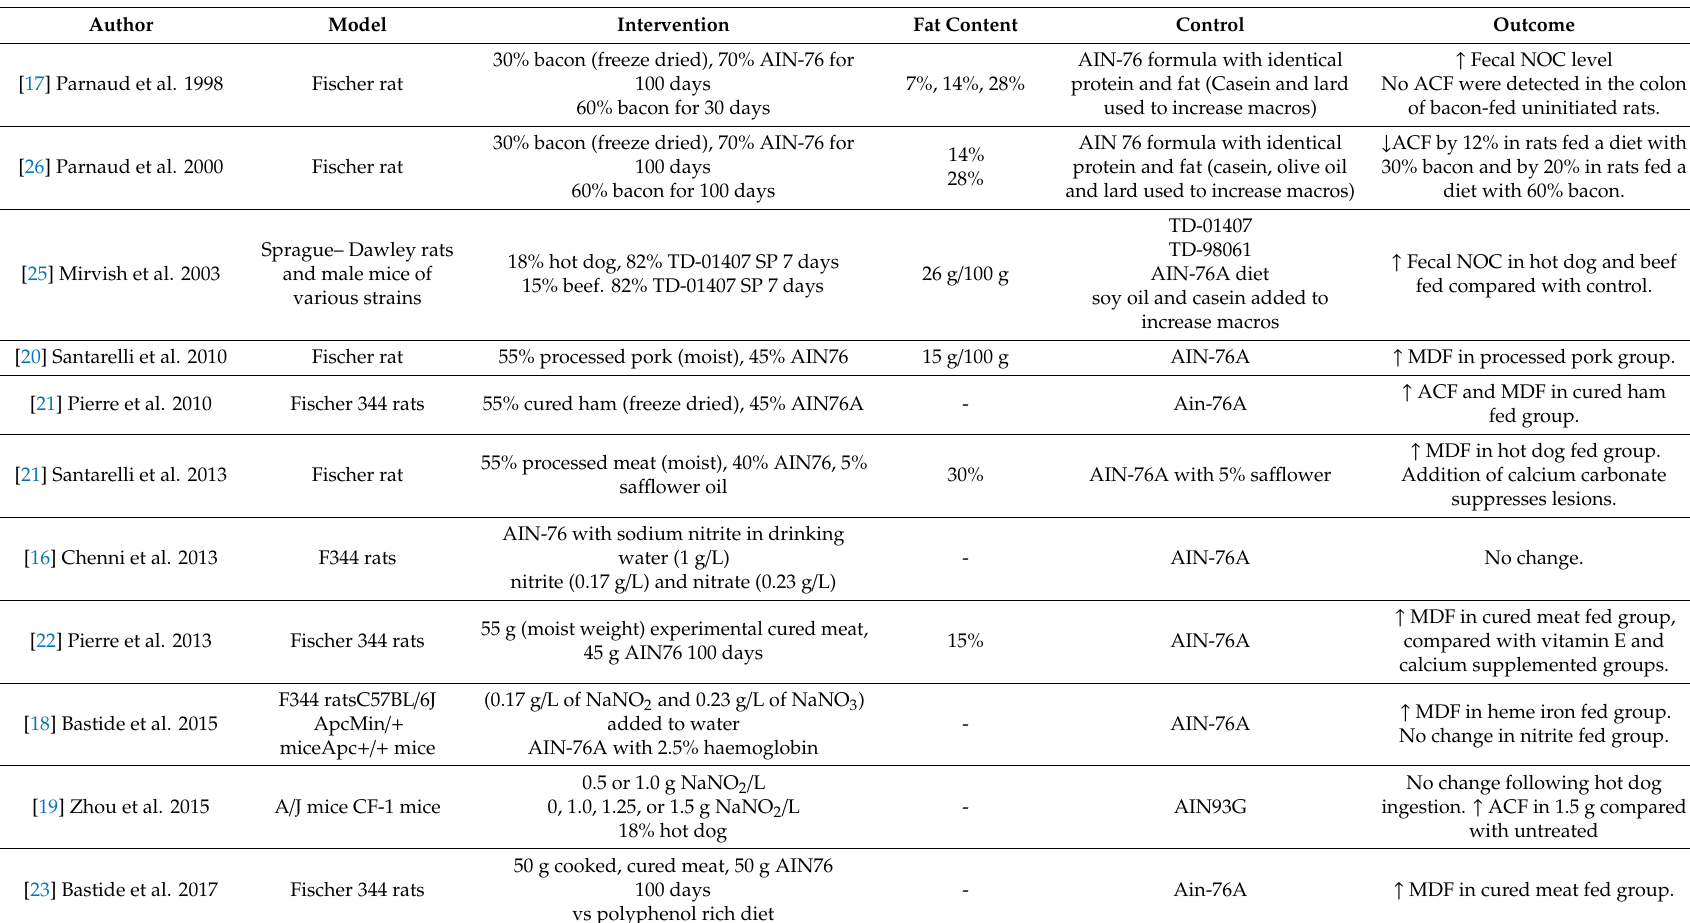
Table 1. Characteristics of animal studies assessing colorectal cancer and nitrite